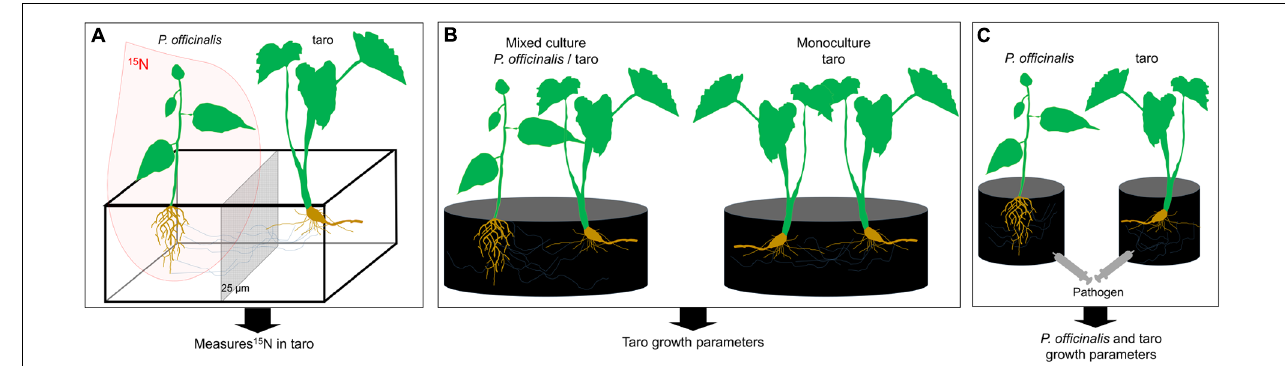
FIGURE 3 | Conceptual experimental design to evaluate role of Funneliformis in the nitrogen transfer from Pterocarpus to taro through CMNs (A) , in the potential benefit of Pterocarpus-taro associations (B) , and in plant pathogen defense (C) . For the three experimental design, all compartments are filled with sterile growth substrate and amended with nutritive solution [without N for (A) ]. Inoculated ( Funneliformis strain) and non-inoculated (control), are compared. (A) Microcosms, consisting of two plant individuals, set up in compartmented containers subdivided by nylon mesh screens (25 µ m). This type of screen is pervious for fungal hyphae but not for roots and allows the separation between two plants. Three months after planting, an isotopic labeling experiment is conducted utilizing 15 N. Plants are harvested 20 days after labeling. Percentage of root colonized by the inoculated Funneliformis strain and 15 N abundance of taro plants are determined. (B) Pot culture experiments, consisting either to a model of monoculture (taro/taro) or a culture association ( P. officinalis /taro). Plants are harvested after 12 weeks of growth and taro growth parameters are measured. The experiment aims the determination of the “competitor” status of Funneliformis . (C) Pot culture experiments, consisting in taro monoculture, to study the potential role of Funneliformis in plant pathogen defense. Plants are grown for 3 months to allow the establishment of Funneliformis and then are inoculated with a pathogen. Plants are harvested after 4 weeks of growth and growth parameters of both plants are measured. The experiment aims the determination the “ruderal” status of Funneliformis